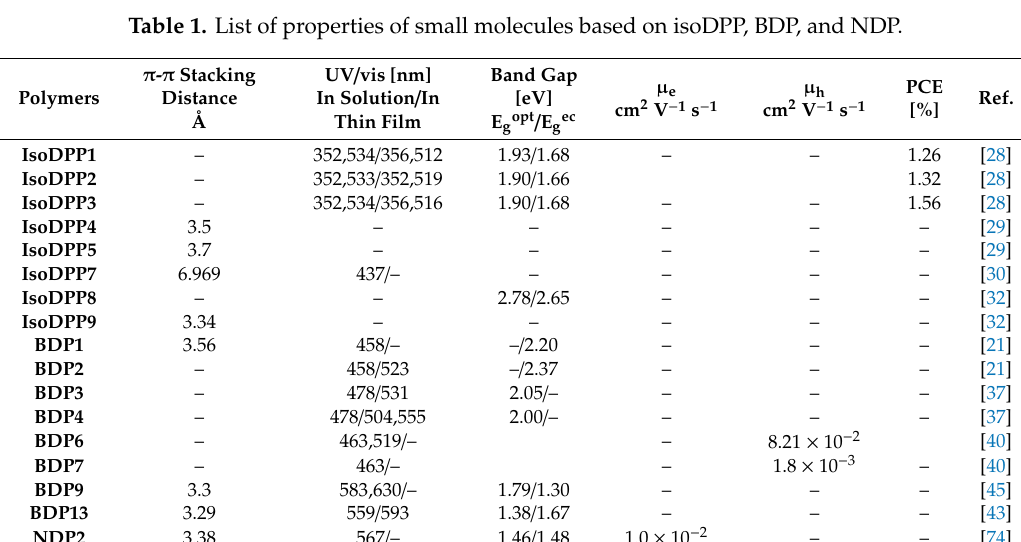
Table 1. List of properties of small molecules based on isoDPP, BDP, and NDP. Polymers